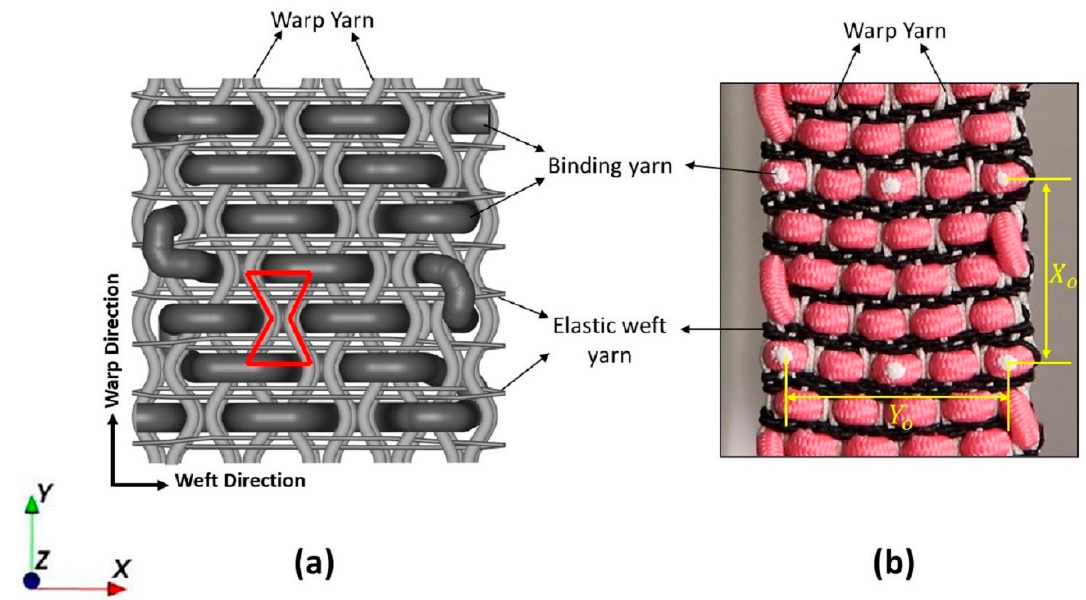
Figure 1. Three dimensional auxetic woven structure: ( a ) schematic representation; ( b ) real